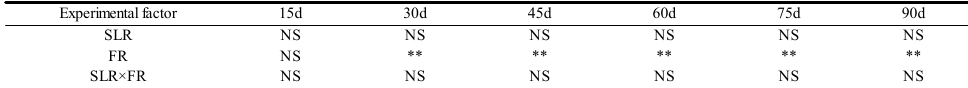
Figure 3. Effects of SLR and FR on the number of fully developed maize plant leaves. Note: Bars represent means ± standard deviation ( n = 3) with different letters indicating significant differences based on LSD ( p ≤ 0.05). SLR, sugarcane leaf return; FR, fertilizer reduction.